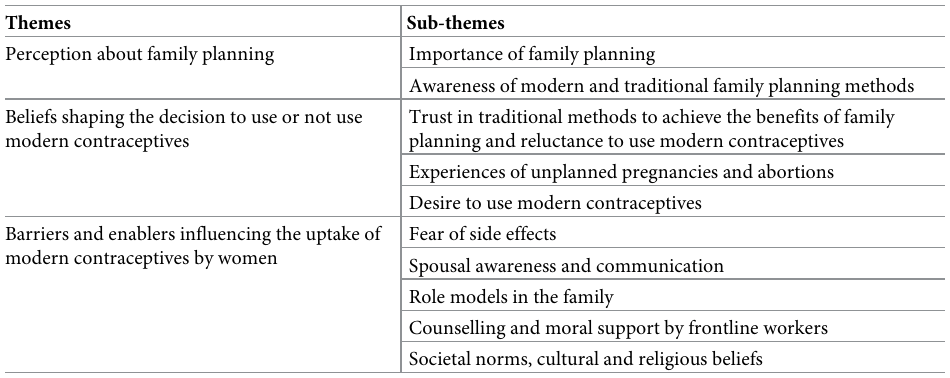
Table 2. Summary of themes and sub-themes.